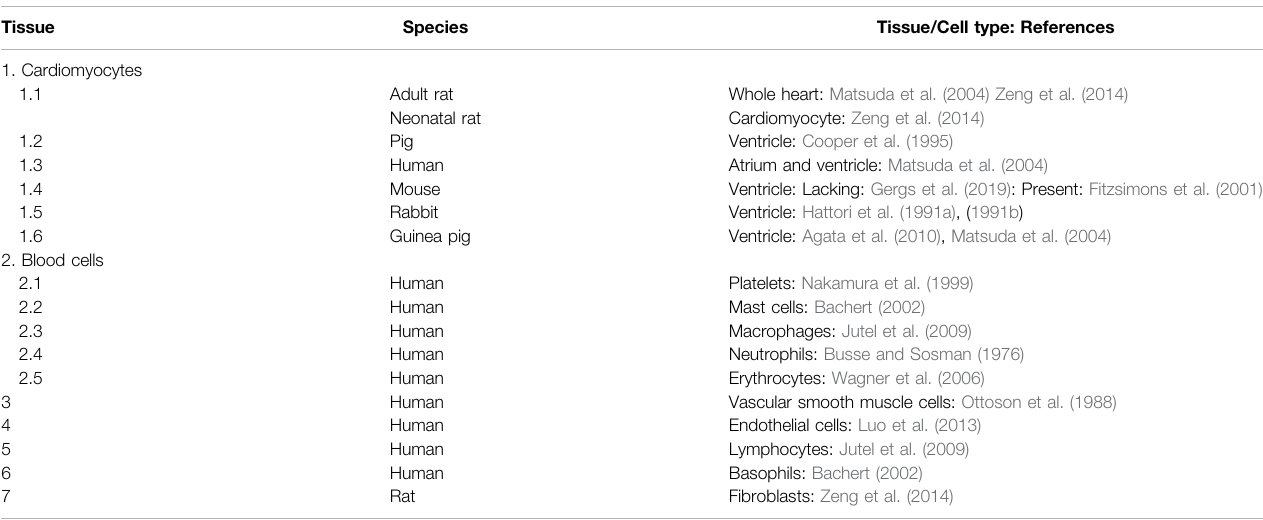
TABLE 5 | Localization of H 2 -histamine receptors. Tissue